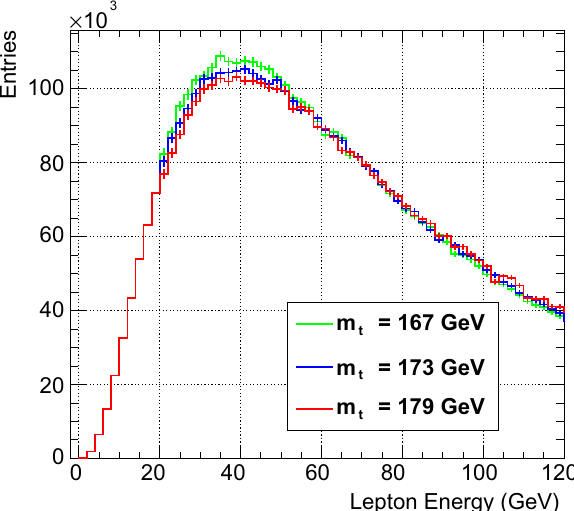
Fig. 1 Energy distribution of lepton at reconstruction level for the top- quark mass of 173 GeV (red color) and the unfolded distribution at parton level (blue color). The energy distribution at reconstruction level is unfolded using an additional sample with the top quark mass of 173 GeV